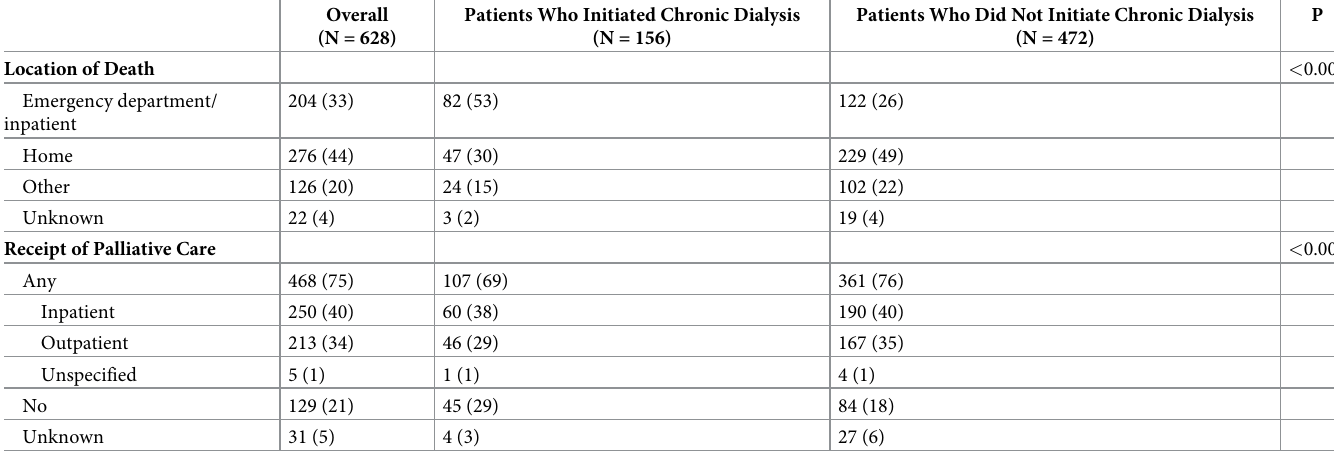
Table 2. Location of death and receipt of palliative care among adults � 70 years old with chronic heart failure and advanced chronic kidney disease between 2008 and 2012 who died during follow-up, overall and stratified by receipt of chronic